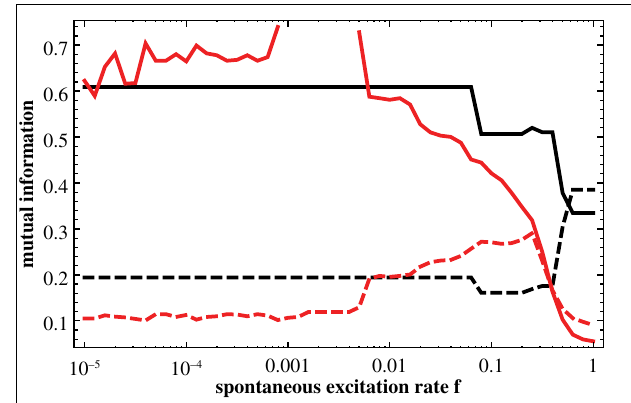
FIGURE 7 | Mutual information as a function of f , measuring the correlation of the predicted similarity matrix Q with modularity (matrix T ; black; full) and with distance to the central node (matrix D ; black; dashed), compared to similar correlation measure between the simulated similarity matrix C and matrices T and D (red; respectively full and dashed); in all cases the 64-node hierarchical graph has been